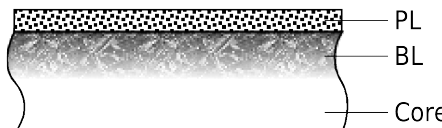
Figure 1. Schematic cross-section of alloy architecture before low-temperature carburization. (Core: alloy core with bulk properties. BL: Beilby layer. PL: Passivating Cr-rich oxide